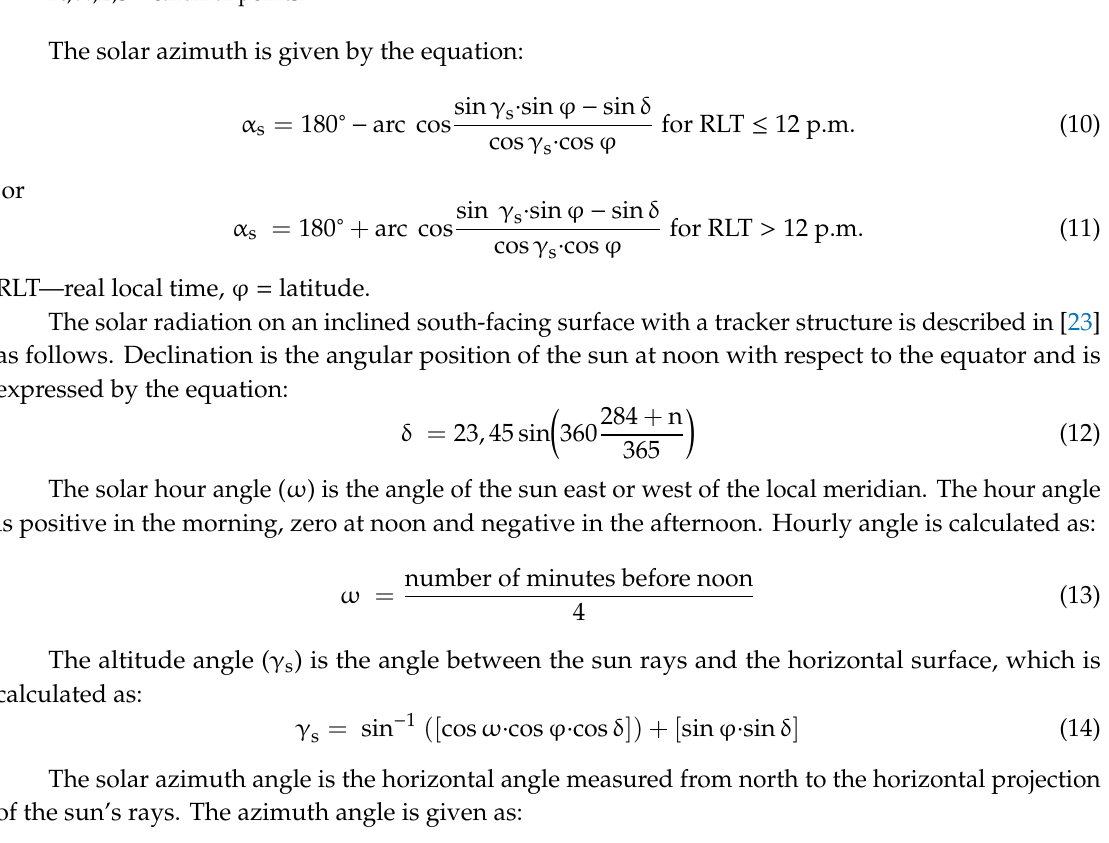
Figure 3. ( a ) Diagram of solar radiation incident on a titled plane. S, N—cardinal points, β —tilt angle, γ —plane azimuth angle, γ s —solar azimuth angle, θ —incidence angle, θ z —solar zenith angle; ( b ) Scheme of sun position in time. SolEtHor—solar hour, SolAzimuth—solar azimuth, N,W,E,S—cardinal